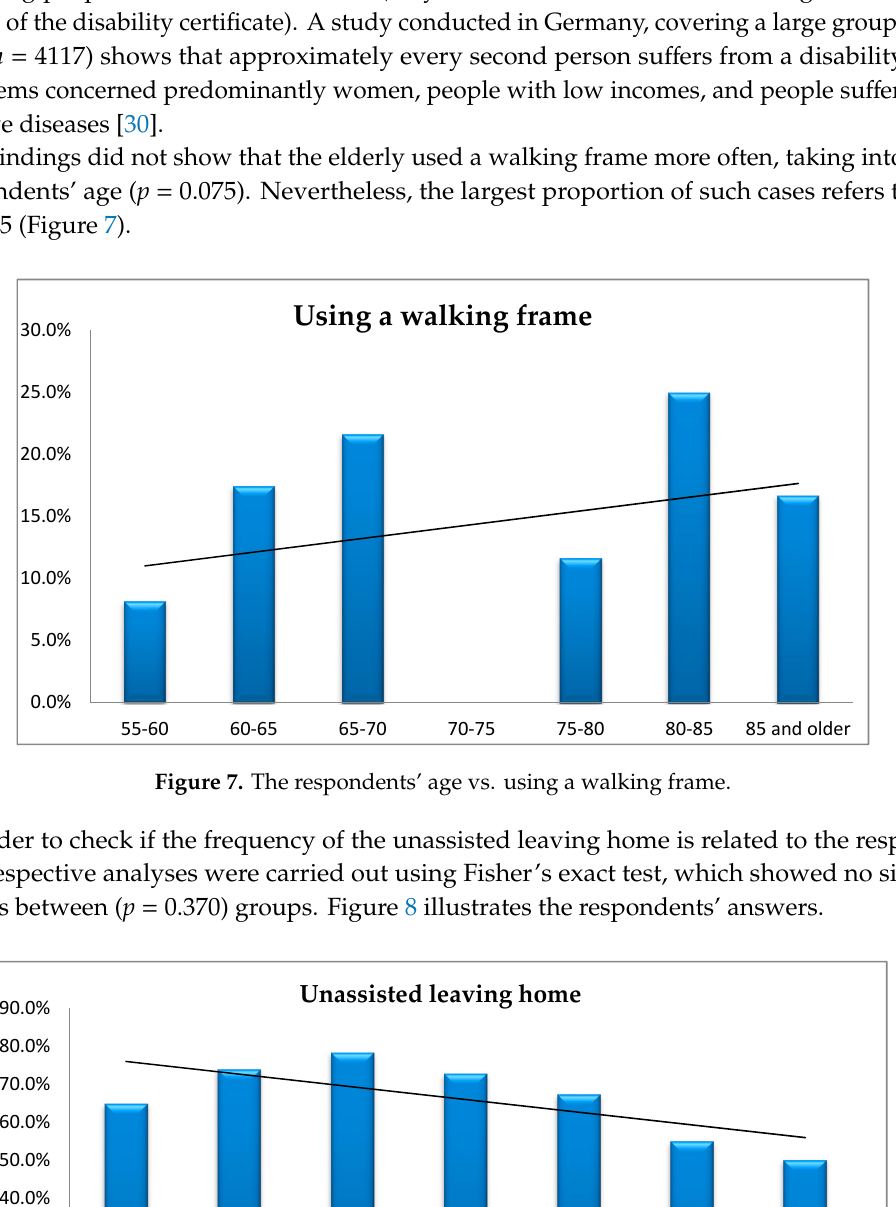
Figure 6. The respondents’ age vs. using a crutch.